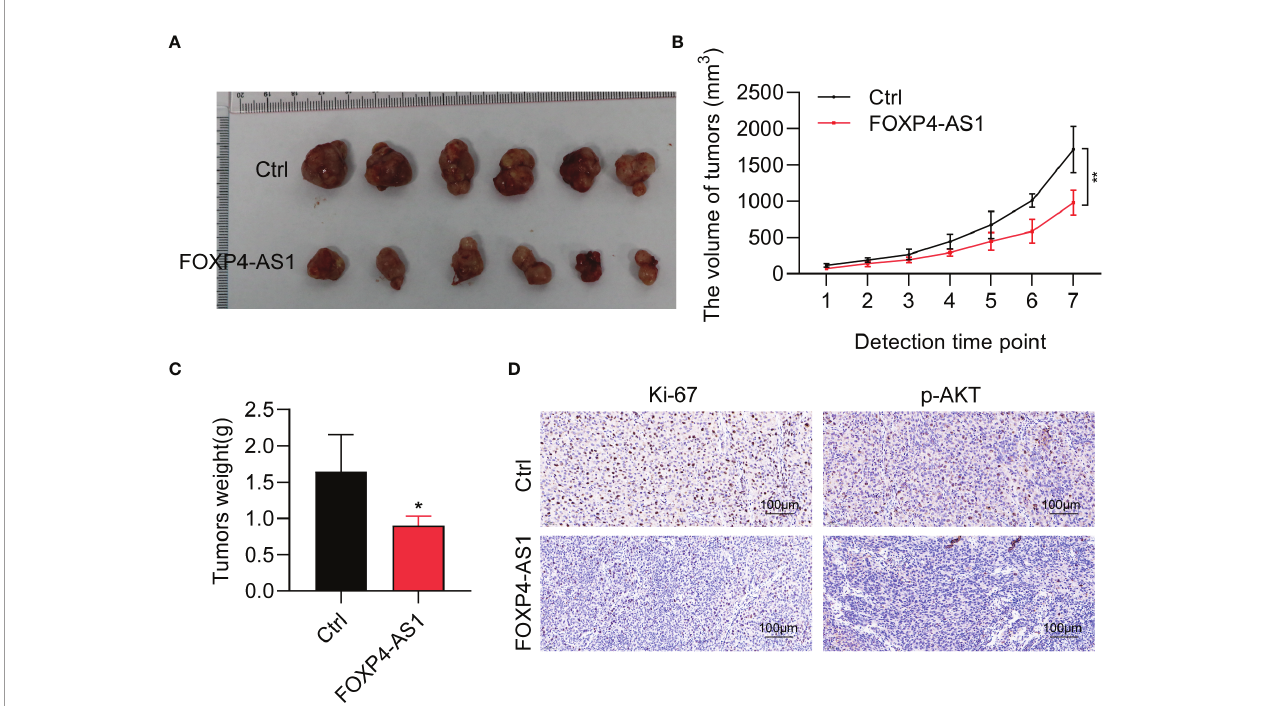
FIGURE 5 | FOXP4-AS1 inhibits tumorigenesis of papillary thyroid carcinoma in nude mice. (A) K1 cells, FOXP4-AS1-overexpressed K1 cells, and control K1 cells were injected in nude mouse fl ank to observe the tumor growth. (B, C) Statistical analysis of the (B) tumor volume and (C) tumor weight between two groups. (D) Ki-67 and p-AKT protein expression in xenografts with FOXP4-AS1 overexpression or control groups by IHC. * p < 0.05; ** p <